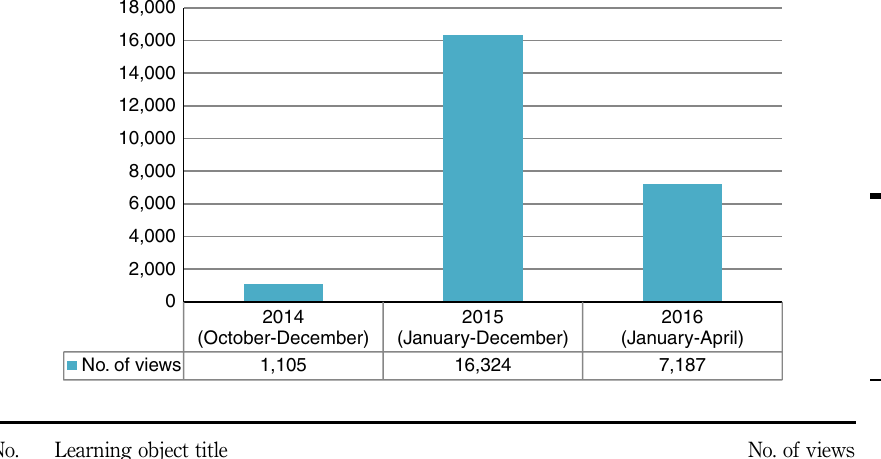
Figure 7. Web access